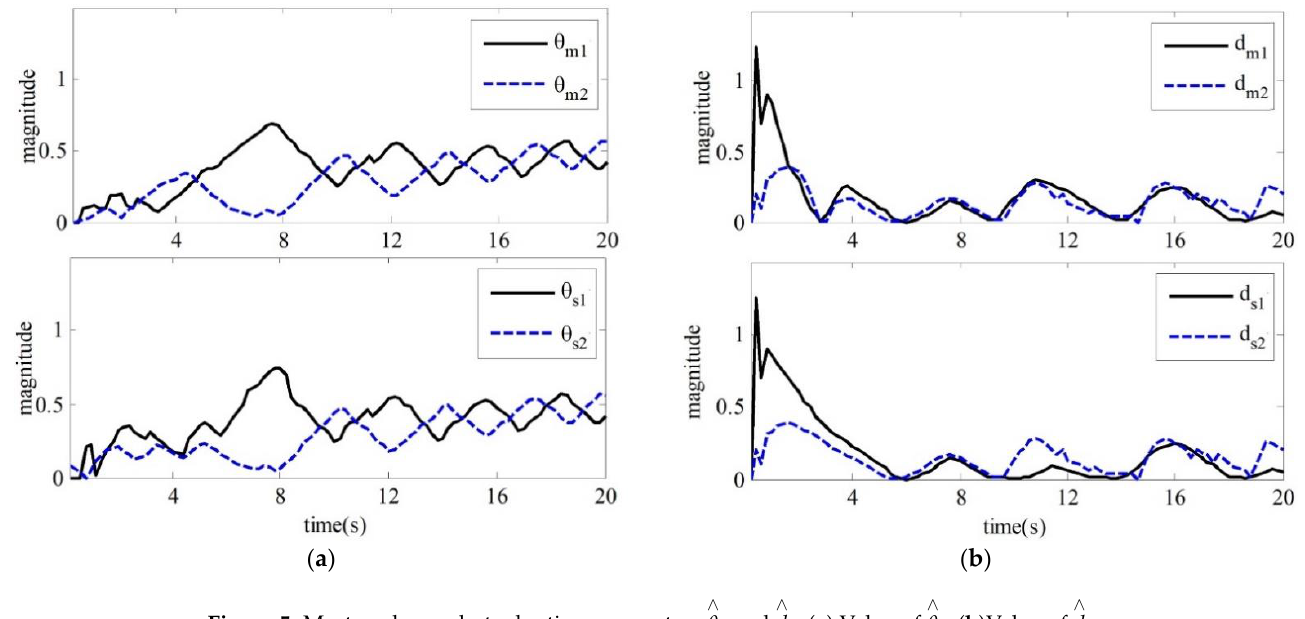
Figure 5. Master–slave robot adaptive parameters Figure 5. Master – slave robot adaptive parameters j